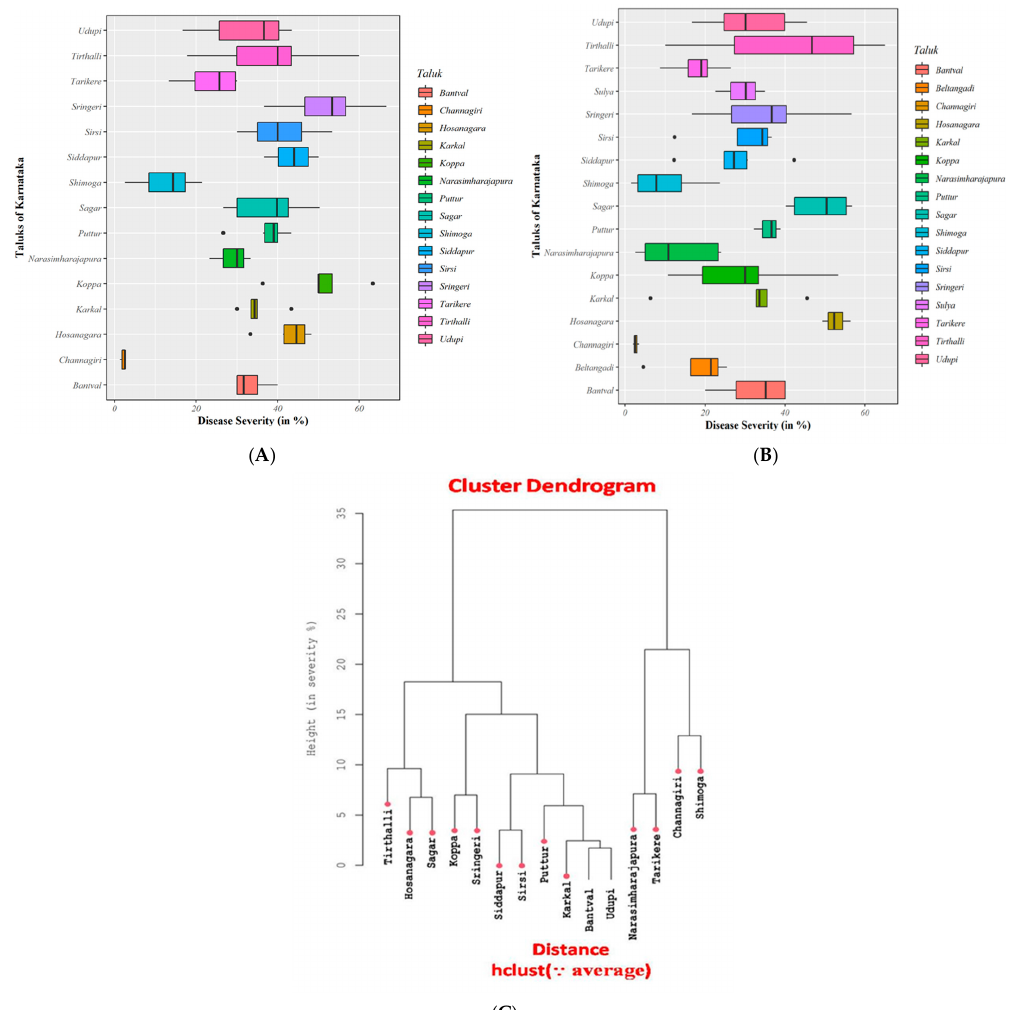
Figure 2. ( A ) Box and whisker plots indicating percent severity rates of FRD on arecanut samples across taluks in Karnataka during 2018. Middle bar = median; box = interquartile range (25th–75th percentile); whiskers (error bars) above and below the box = 90th and 10th percentile, respectively; dots = outliers. ( B ) Box and whisker plots indicating percent severity rates of FRD on arecanut samples across the studied taluks in Karnataka during 2019. Middle bar = median; box = interquartile range (25th–75th percentile); whiskers (error bars) above and below the box = 90th and 10th percentile, respectively; dots = outliers. ( C ) Agglomerative hierarchical cluster analysis of FRD using the average linkage method identified four main clusters among 18 taluks in Karnataka, India.